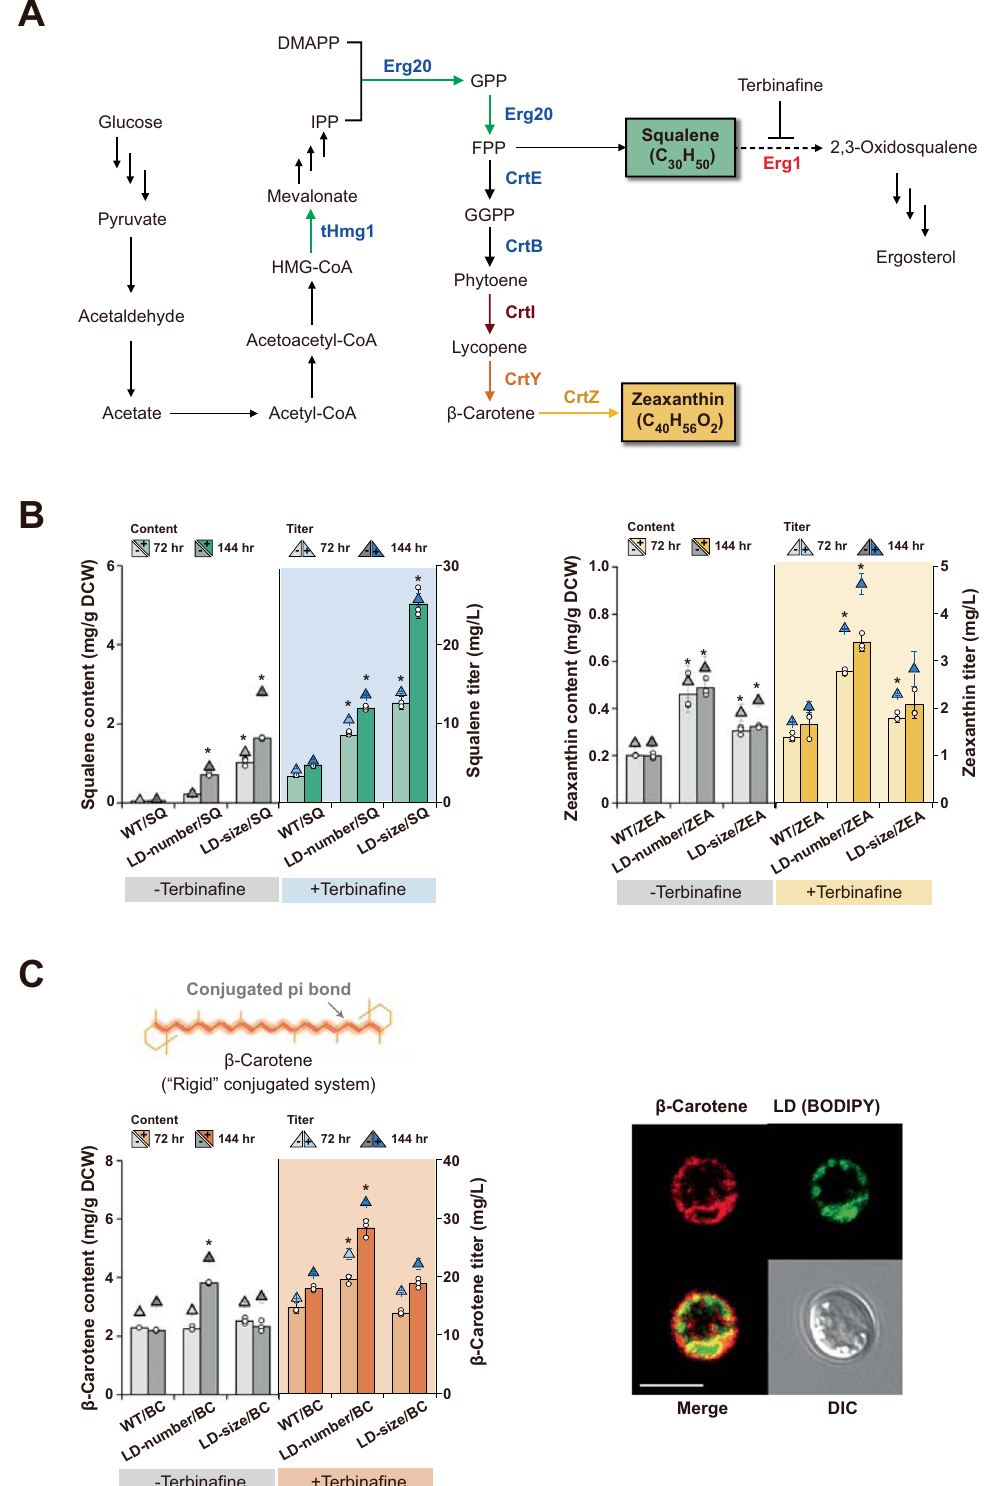
can be applied to other types of lipid transport systems and even regulated oil-phase compartments within the aqueous cytosol of metabolic systems. As the hydrophobicity and fl exibility of lipids cells, selective partitioning of speci fi c precursors, intermediates, are easily predicted from their chemical structures, their com- and products of lipid metabolism may be achieved in these phase- patible LDs can also be readily determined. Moreover, the surface separated organelles. Given the full control over the dynamics localization of target lipids likely increases their opportunity to and functions of LDs, we envision that these unique phase- interact with many classes of LD surface proteins, mediating separated organelles will serve not only as warehouses with relevant metabolic processes. Moreover, as LDs represent well- controlled entry and exit of various hydrophobic molecules, NATURE COMMUNICATIONS| (2022) 13:3612